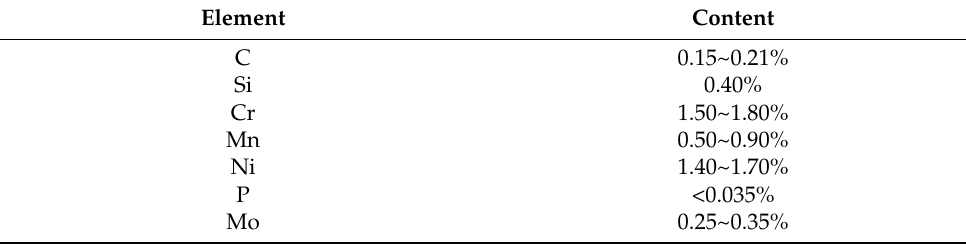
Table 1. Chemical composition of